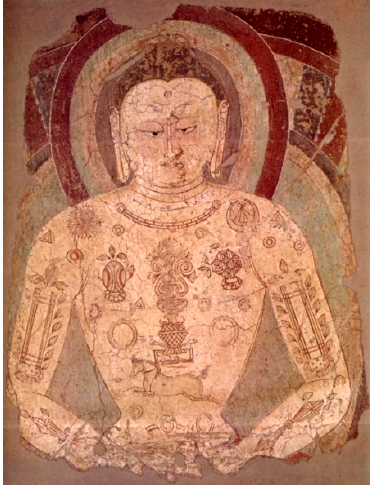
Figure 23. Vairocana with crescent moon and sun symbols. Painting from Balawaste, Central Asia, eighth c. National Museum, New Delhi, Stein Collection of Central Asian Antiquities. Photograph courtesy of John C. Huntington. See also http://museumsofindia.gov.in/repository/record/nat_del-99-1-46-4635.